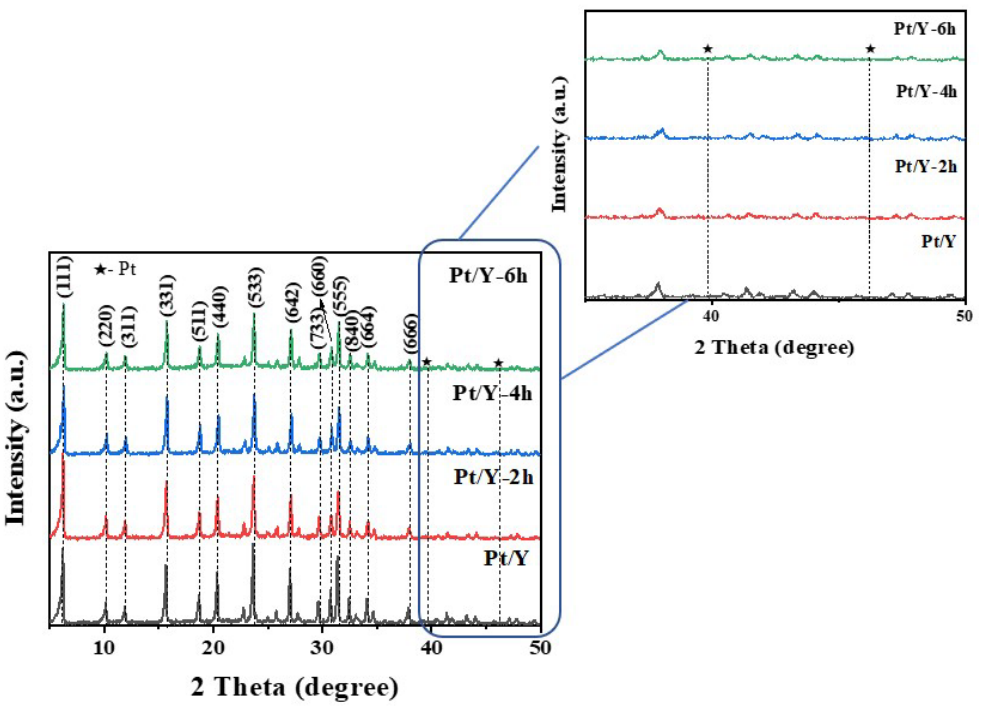
Figure 1. Powder X-ray diffraction patterns of the Pt/Y zeolites. The asterisks indicate Pt peaks. Table 1. Textural properties of the Pt/Y